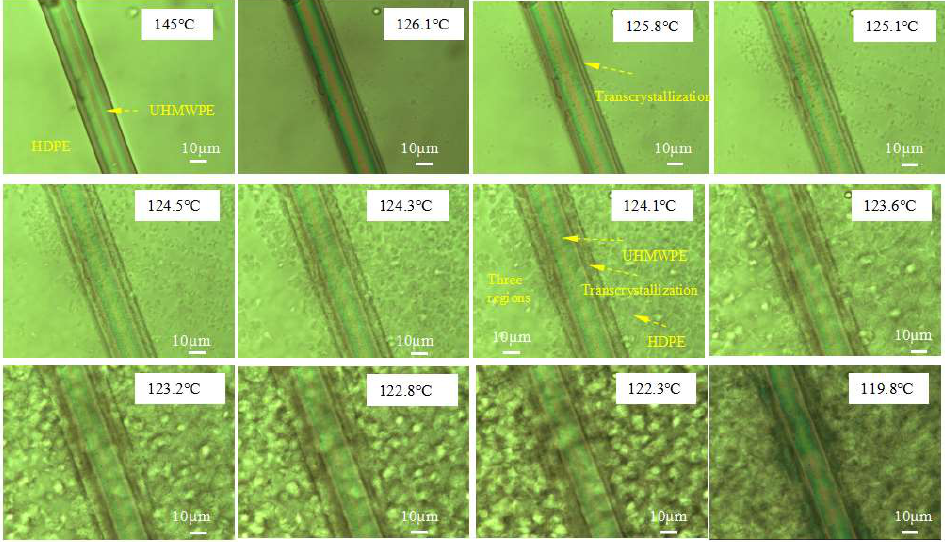
Figure 9. POM experiment on the single UHMWPE fiber–HDPE composite at various temperatures.